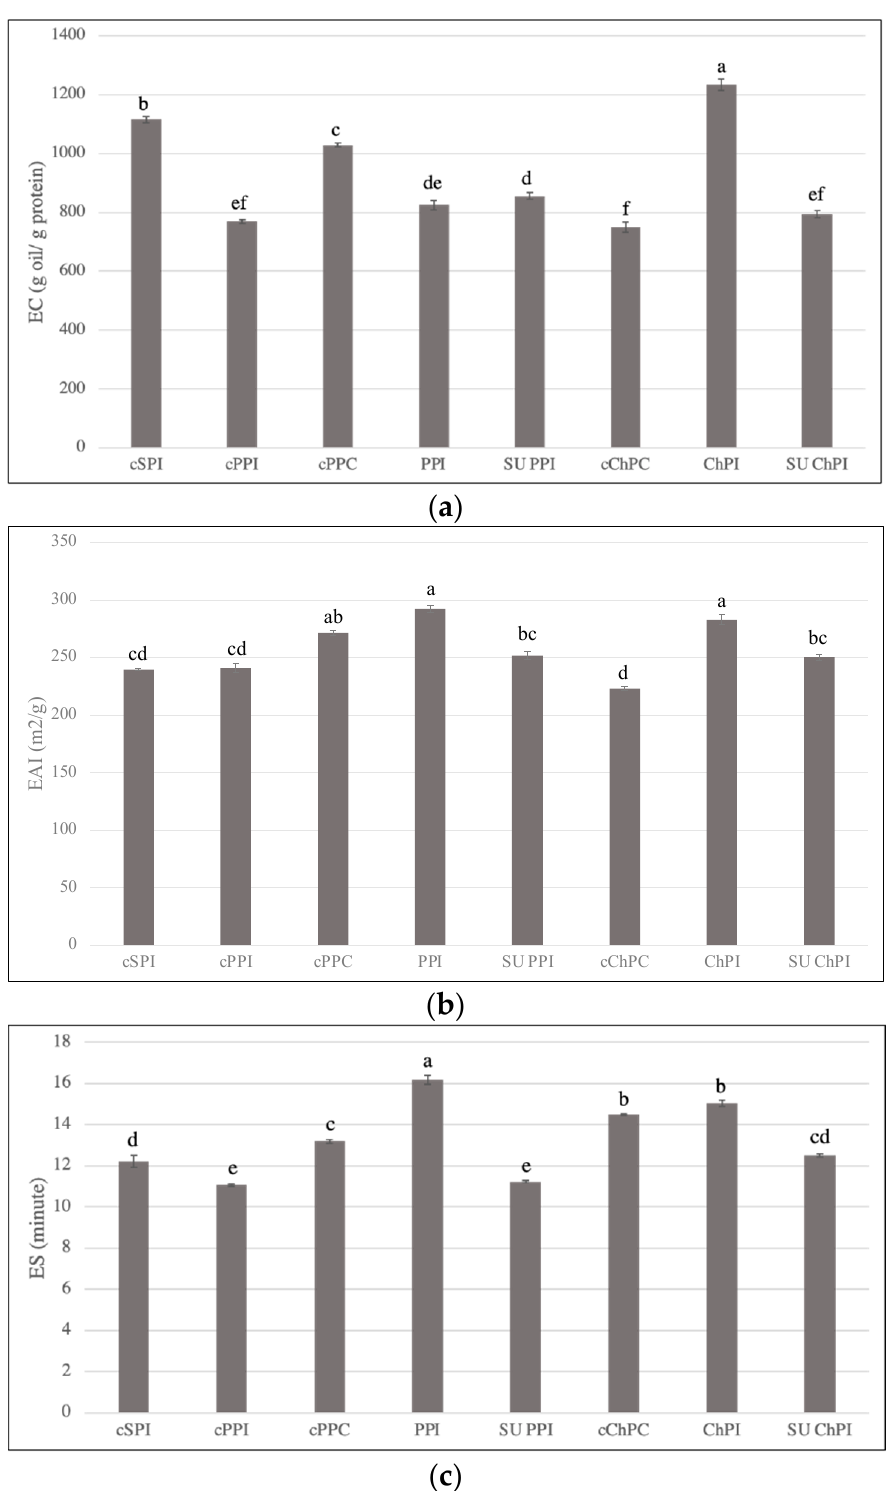
Figure 4. Protein emulsion capacity, EC, ( a ) emulsion activity index, EAI, ( b ) and emulsion stability, ES, ( c ) of benchtop and scaled-up pea and chickpea protein isolates (PPI, SU PPI, ChPI, SU ChPI), as well as commercial SPI, PPI, PPC, and cChPC. Error bars represent standard error (n = 3). Lowercase letters above the bars denote significant differences among the samples, according to the Tukey-Kramer multiple means comparison test ( p < 0.05).